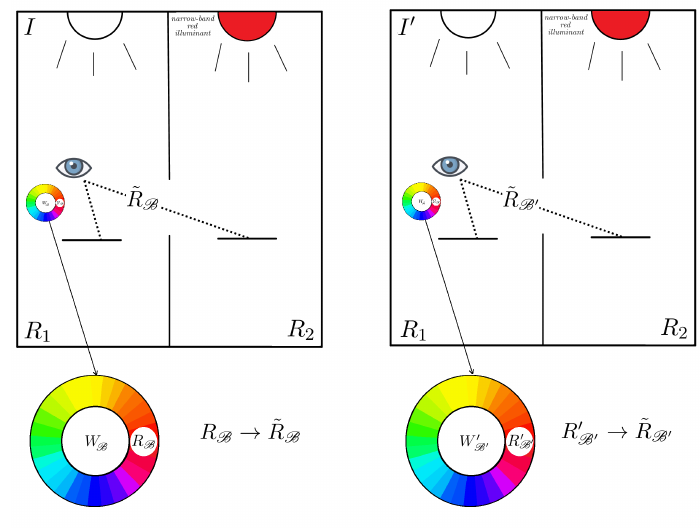
Figure 6. Depiction of Yilmaz’s second experiment with the notation established in Section